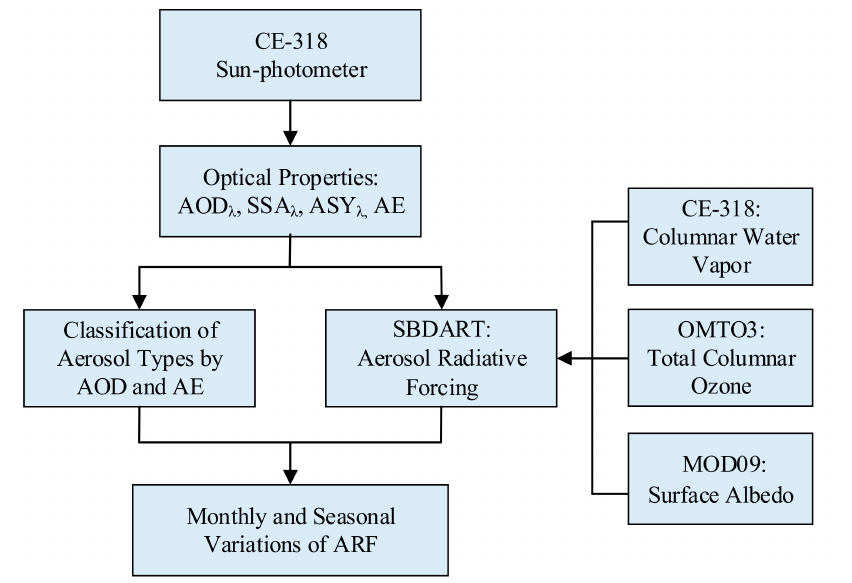
Figure 1. The research framework of aerosol optical properties and radiative effects over